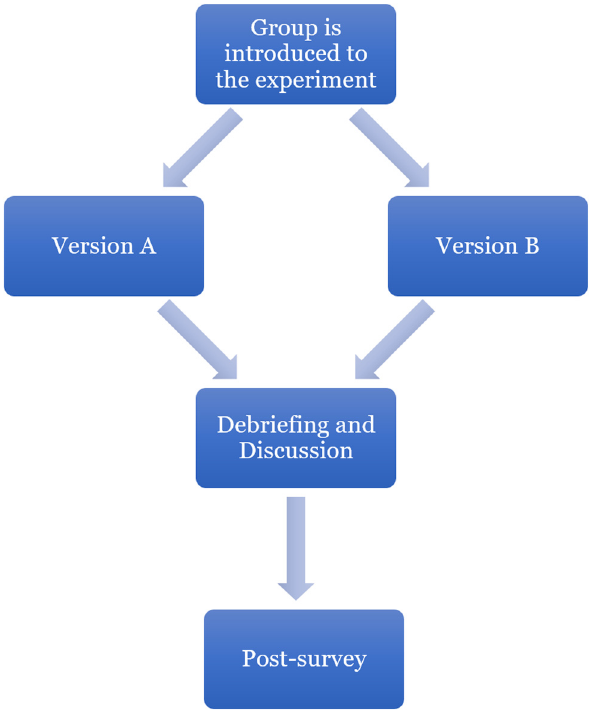
Figure 1: Process overview – RAVE/C -